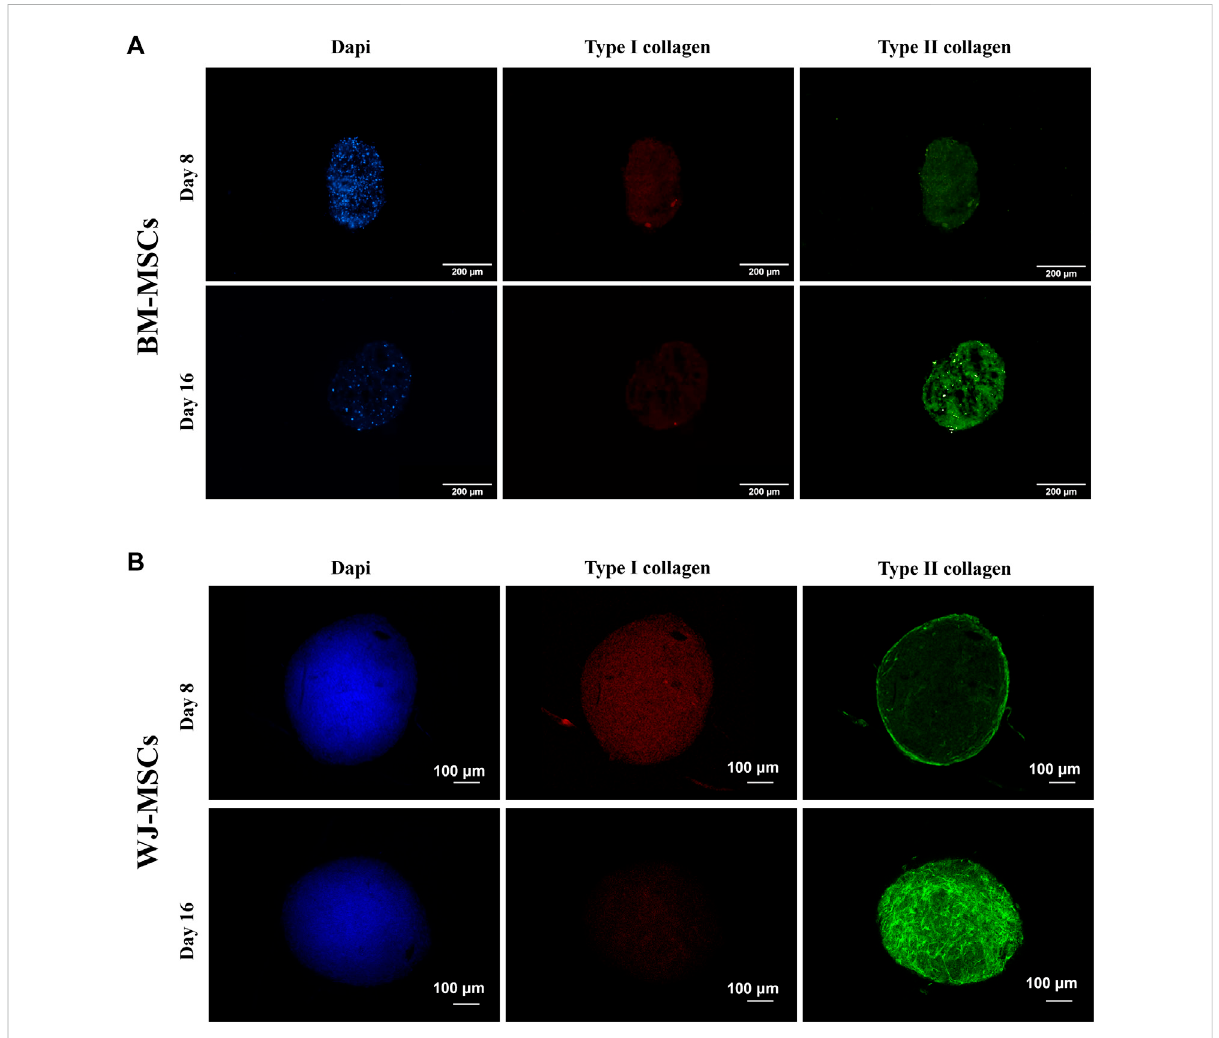
FIGURE 7 Immuno fl uorescence of hBM-MSCs (A) and hWJ-MSCs (B) in 3D high-density cultures supplemented with 10 ng/ml of hTGF- β 1 and acquired at different time-point. Type I collagen was stained in red and type II collagen in green. DAPI was used to counterstain the nuclei (blue) Scale bars were 200 microns for BM culture and 100 microns for WJ